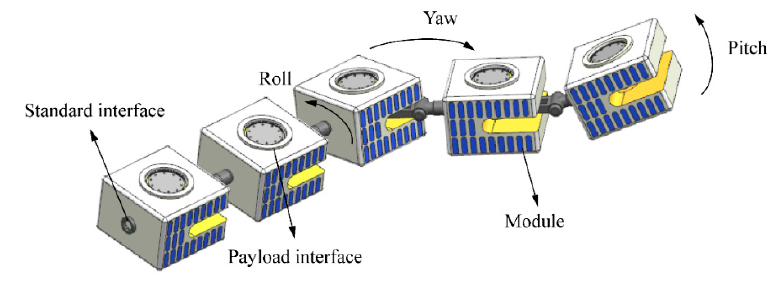
Figure 1. Model of SMSRS with five